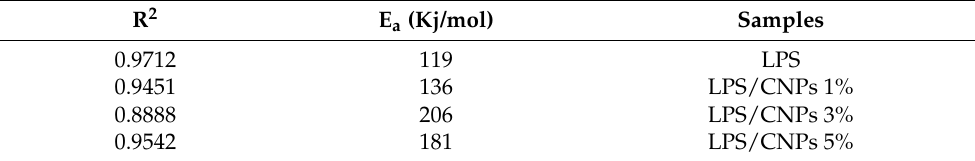
Table 4. The E a and the correlation coefficient calculated by the Kissinger method.